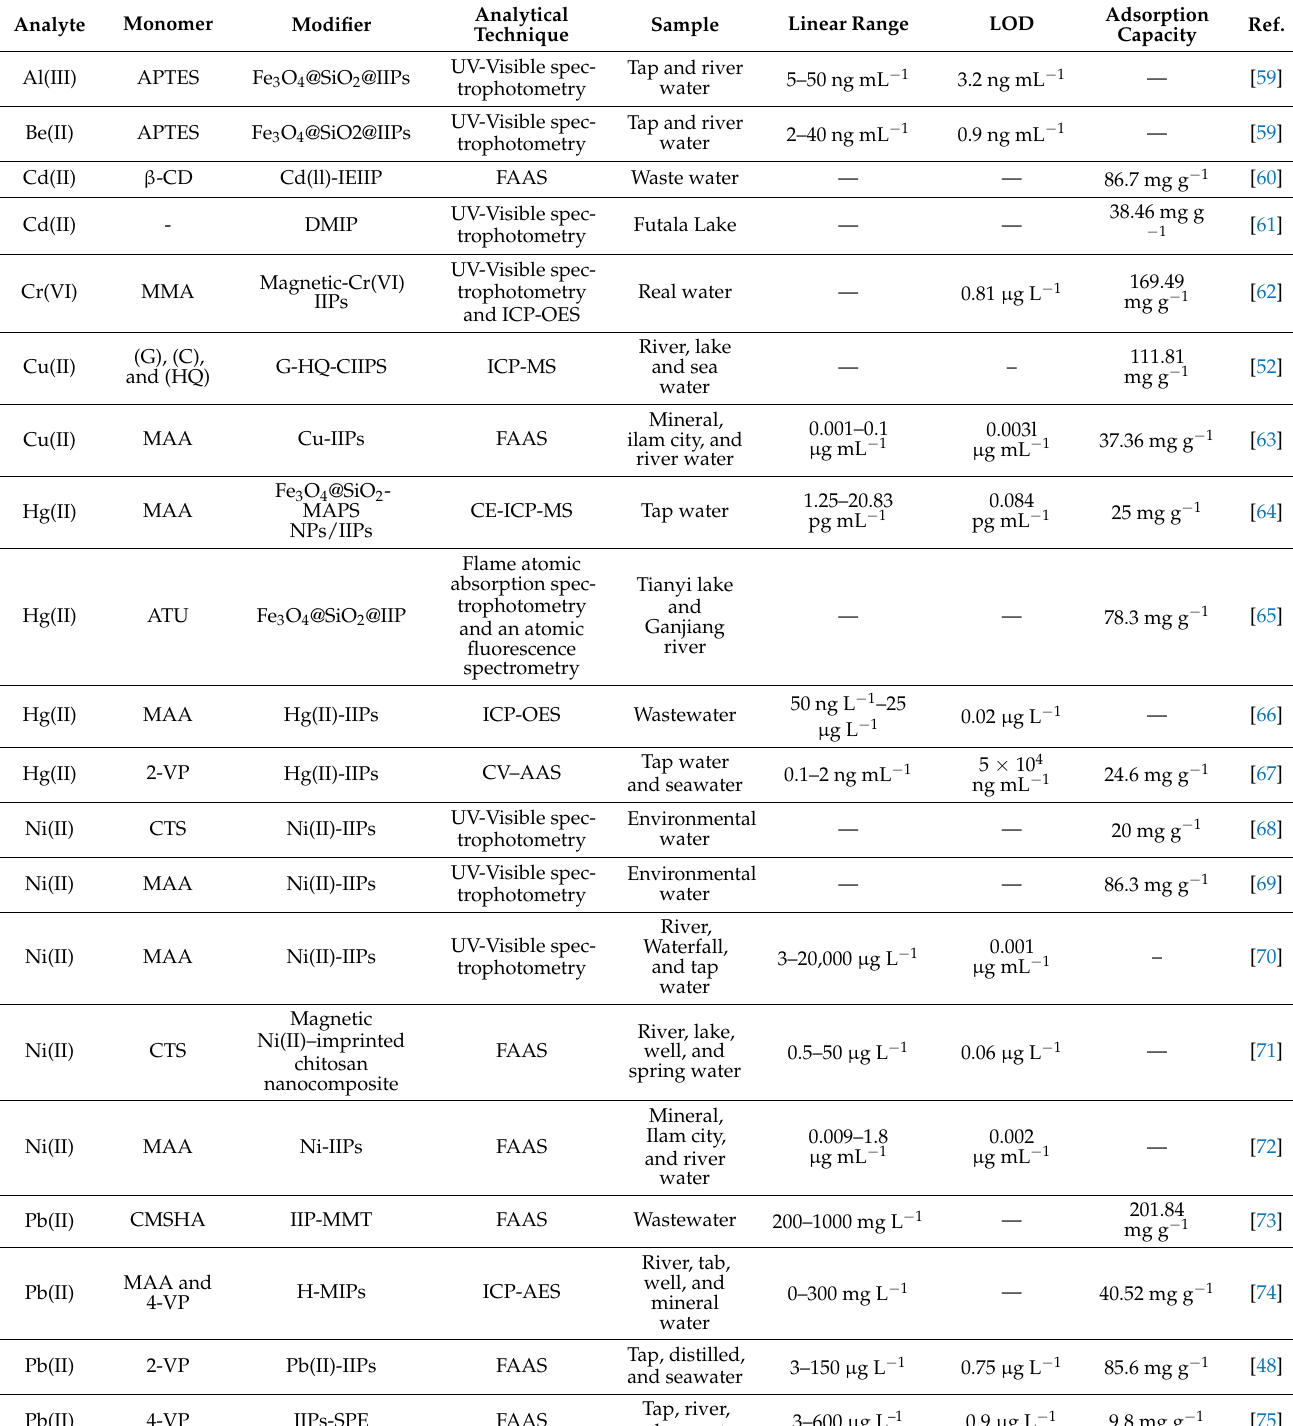
Table 1. Application of MIPs for solid phase extraction of heavy